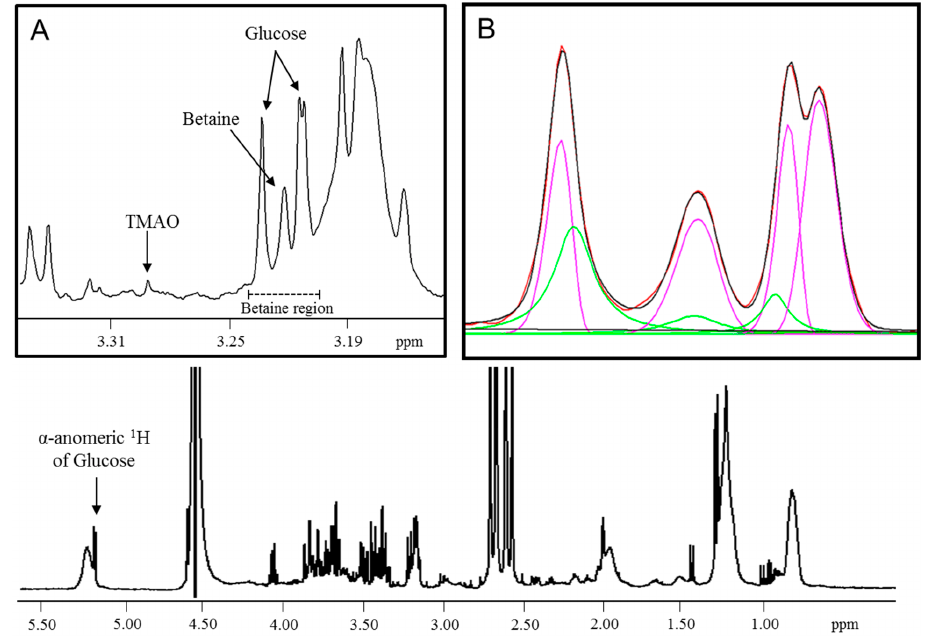
Figure 1. 1D 1H CPMG NMR spectrum of serum used for modeling the betaine peak. ( A ) Expansion of the spectrum where the betaine region is extracted for lineshape deconvolution. ( B ) The experimental (red) spectrum overlaid with a mathematical fit (black) from a composite of lognormal (pink) and Lorentzian (green) lineshapes after subtraction of the baseline in the betaine region. ppm = parts per million; CPMG, Carr – Purcell – Meiboom – Gill; NMR, nuclear magnetic resonance.